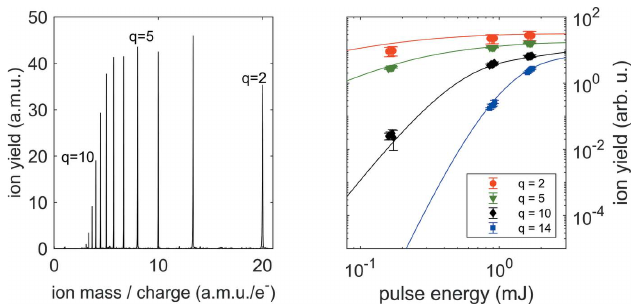
Figure 5 Left: a representative time-of-flight mass spectrum of multiphoton ionized Ar atoms. Photon energy was h (cid:3) = 1200 eV, pulse energy was E p = 1.0 mJ, corresponding to 5 (cid:4) 10 12 photons per pulse. Right: measured CSDs as a function of pulse energy at h (cid:3) = 1200 eV for selected charge states compared with the best-fitting curves from the XATOM calculations, yielding the parameters reported in the first row of Table